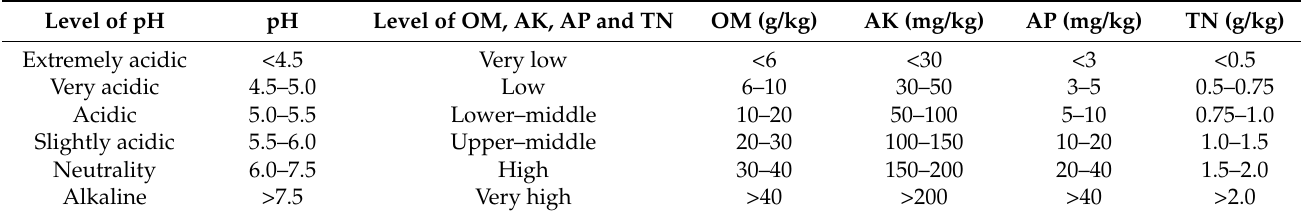
Table 3. Classification of soil properties in